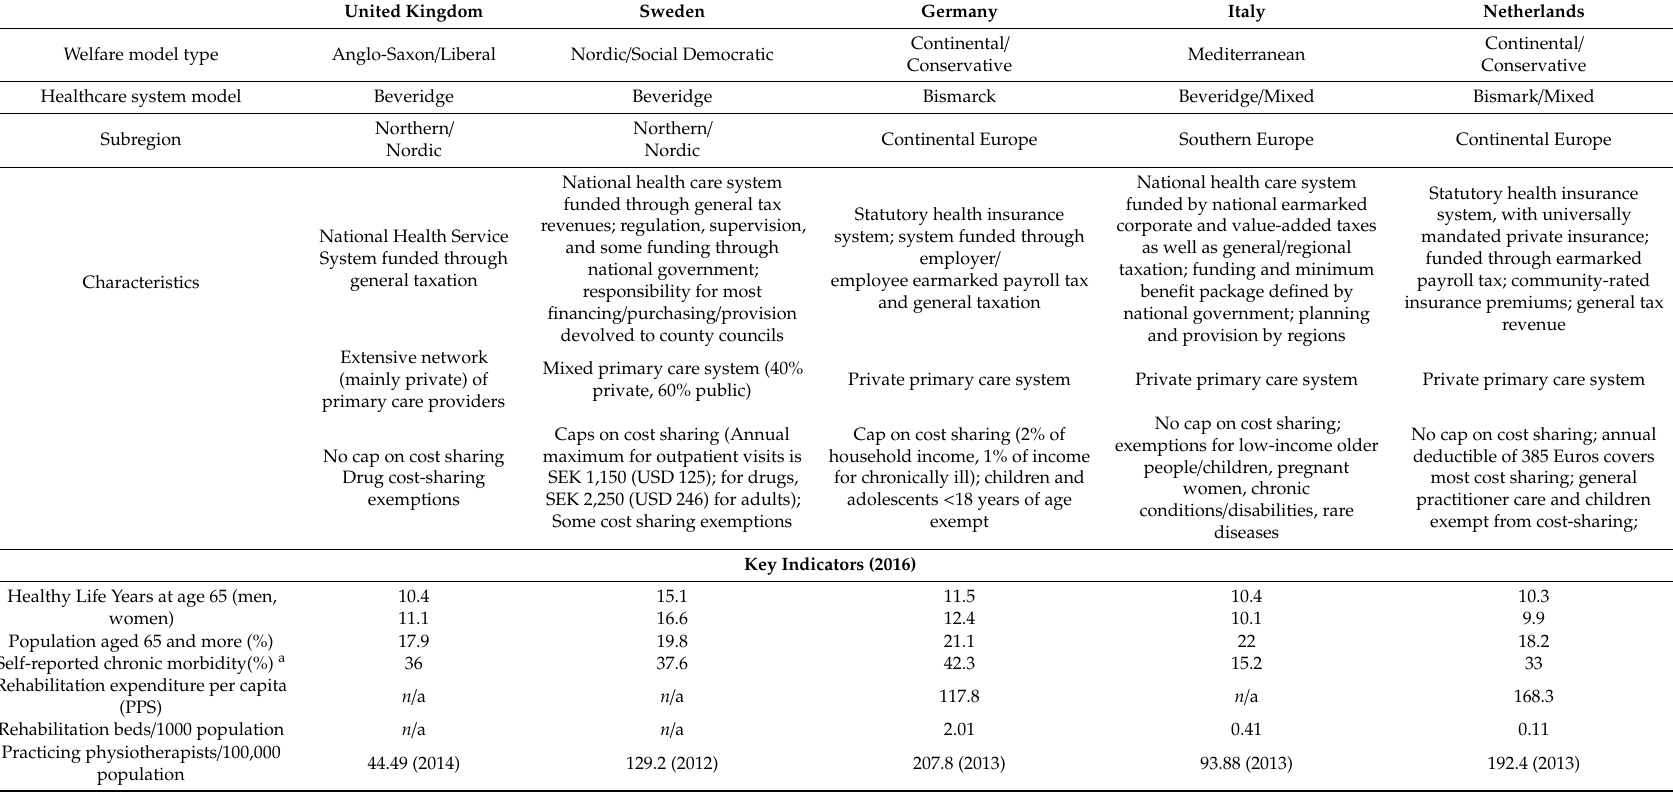
Table 1. Basic information on countries included in the